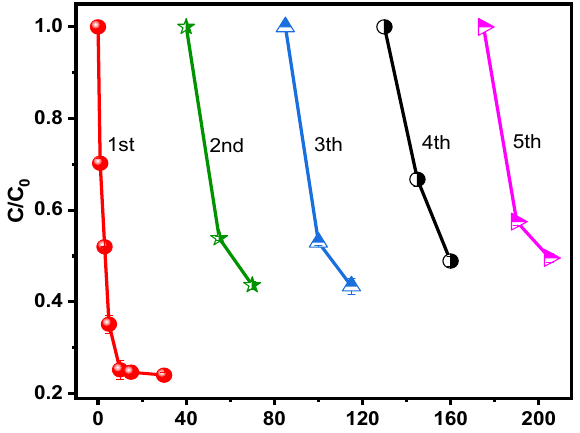
Figure 8. Reusability of the Fe-Mo/rGO catalyst for SMT removal. ([SMT] 0 = 0.076 mM, [Catalyst] = 0.2 g/L, [H 2 O 2 ] 0 = 20 mM, pH = 6.57, T = 25 °C).